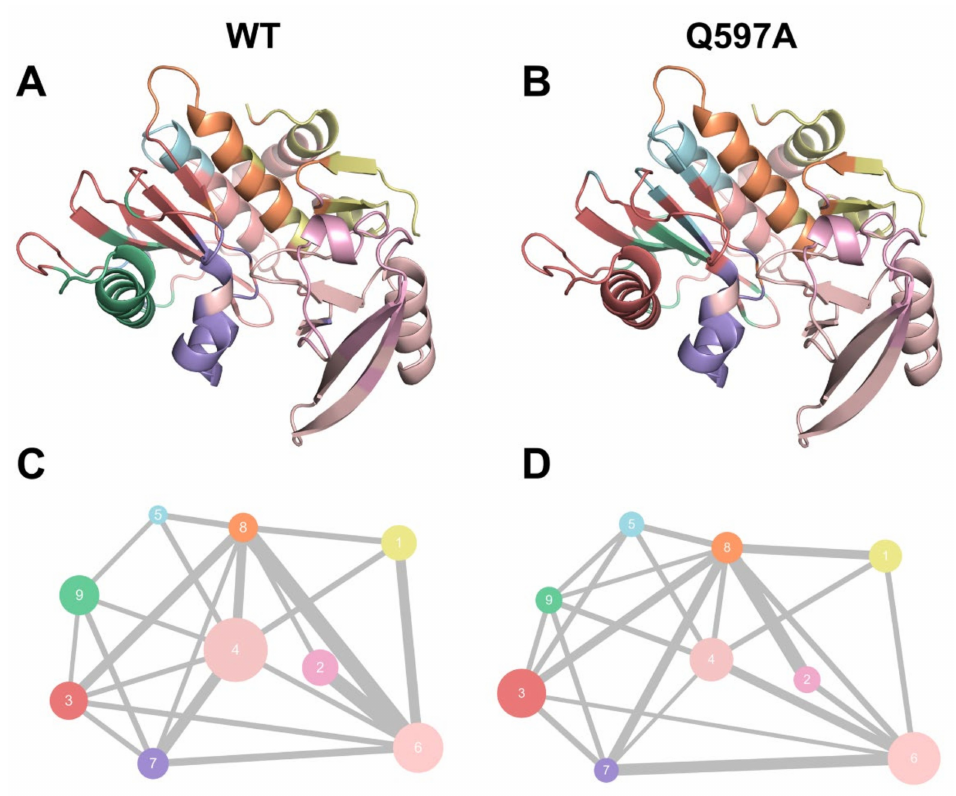
Figure 6. Colored community network of WT ( A , C ) and Q597A ( B , D ) systems. Each sphere represents an individual community with its size correlated with the number of